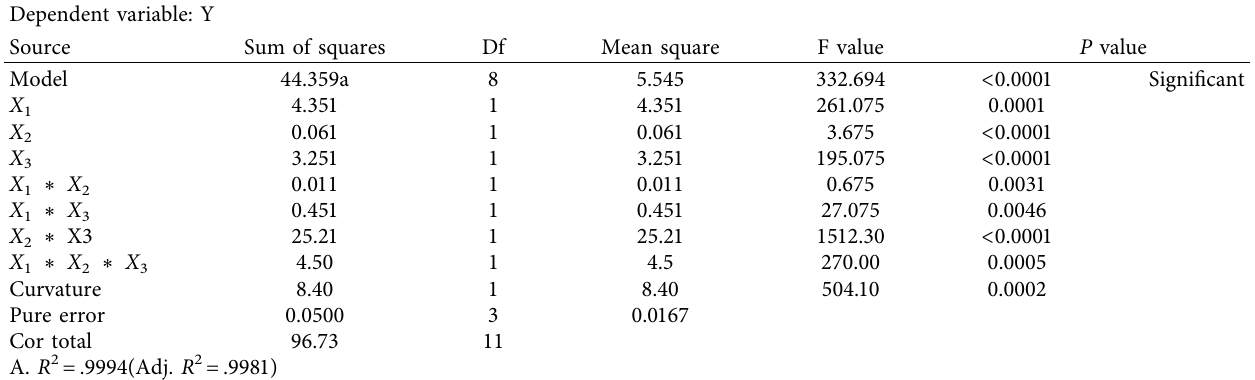
Table 7: Analysis of variance of interactive factors.